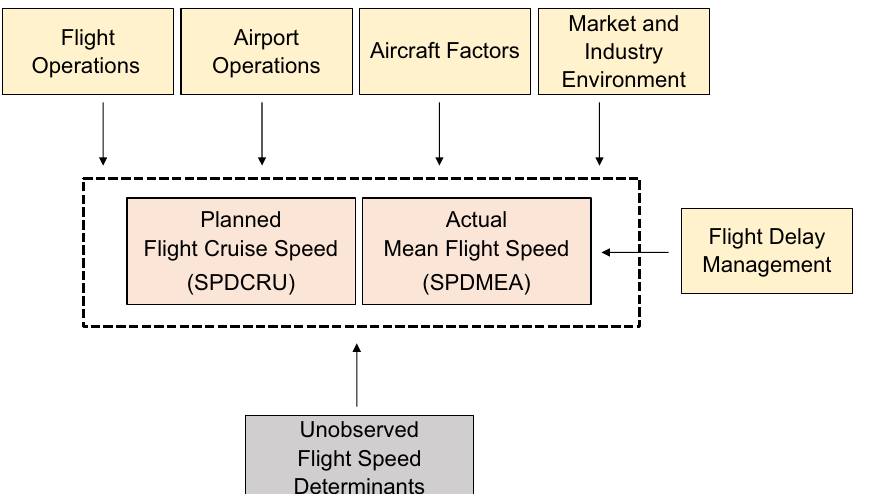
Figure 1. Conceptual model of flight speed